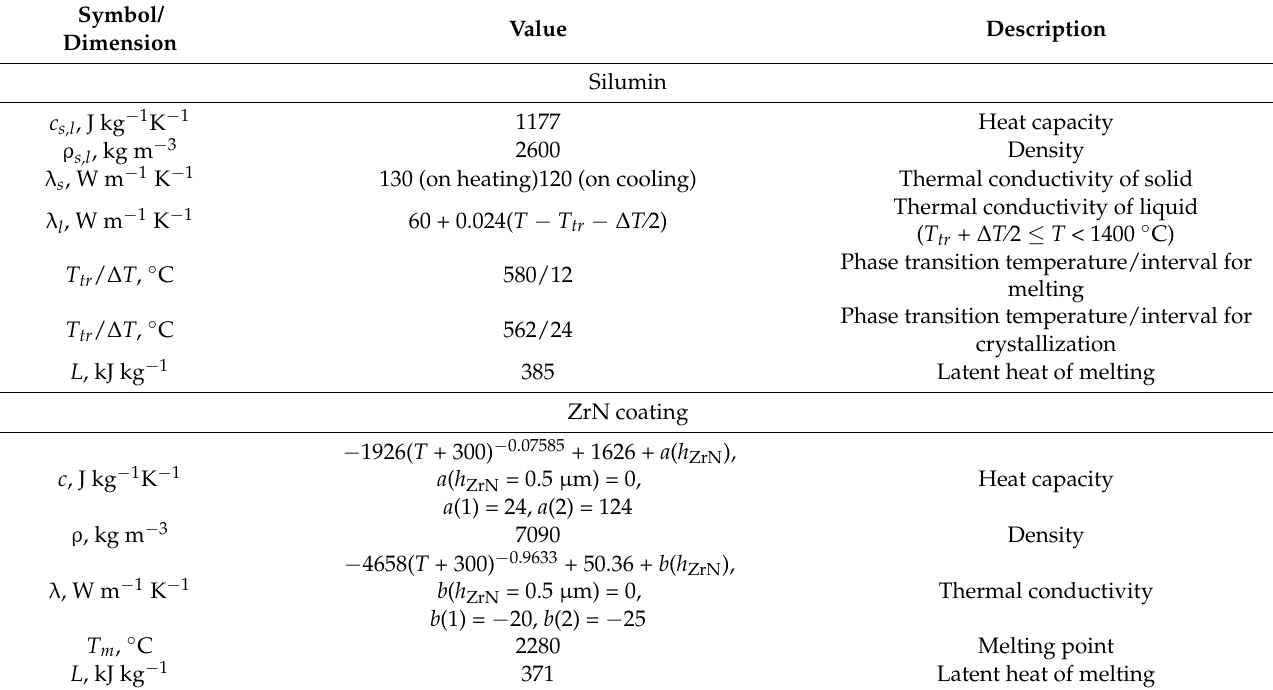
Table 2. Thermal and physical characteristics of the substrate and coating